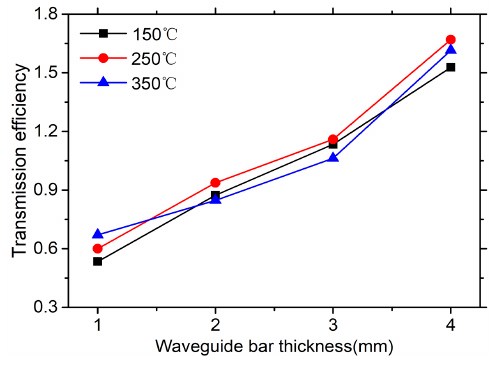
Figure 9. The transmission efficiency of the SH0* wave versus waveguide thicknesses.